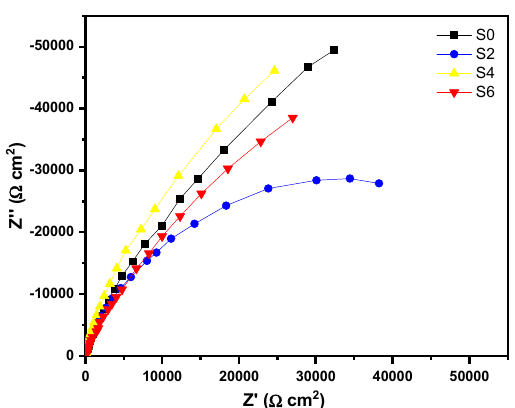
Figure 4. Nyquist plots of experimental (symbols) and fitted (lines) data for samples S0, S2, S4 and S6.